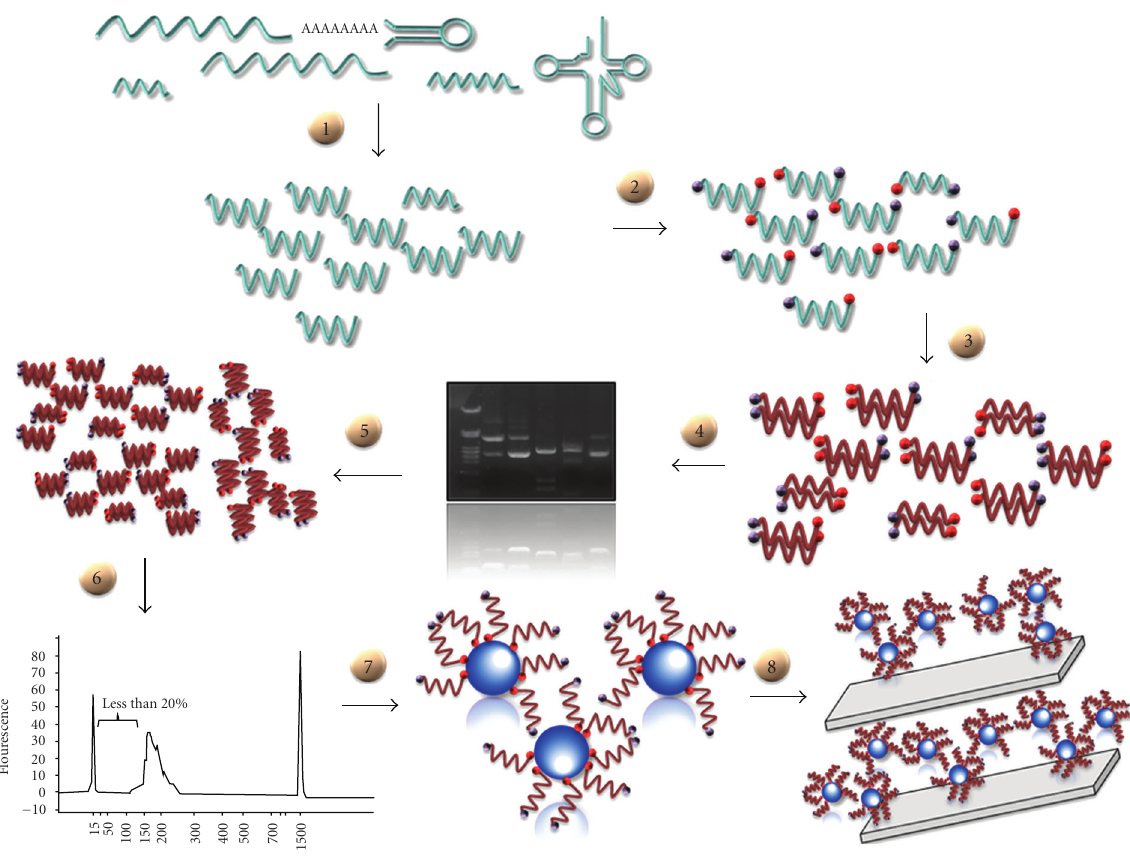
Figure 2: Library preparation and clonal amplification. Schematic representation of a workflow for library preparation in RNA-Seq experiments on the SOLiD platform. In the figure is depicted a total RNA sample after depletion of rRNA, containing both polyA and non-polyA mRNA, tRNAs, miRNAs and small noncoding RNAs. Ribo-depleted total RNA is fragmented (1), then ligated to specific adaptor sequences (2) and retro-transcribed (3). The resulting cDNA is size selected by gel electrophoresis (4), and cDNAs are PCR amplified (5). Then size distribution is evaluated (6). Emulsion PCR, with one cDNA fragment per bead, is used for the clonal amplification of cDNA libraries (7). Purified and enriched beads are finally deposited onto glass slides (8), ready to be sequenced by